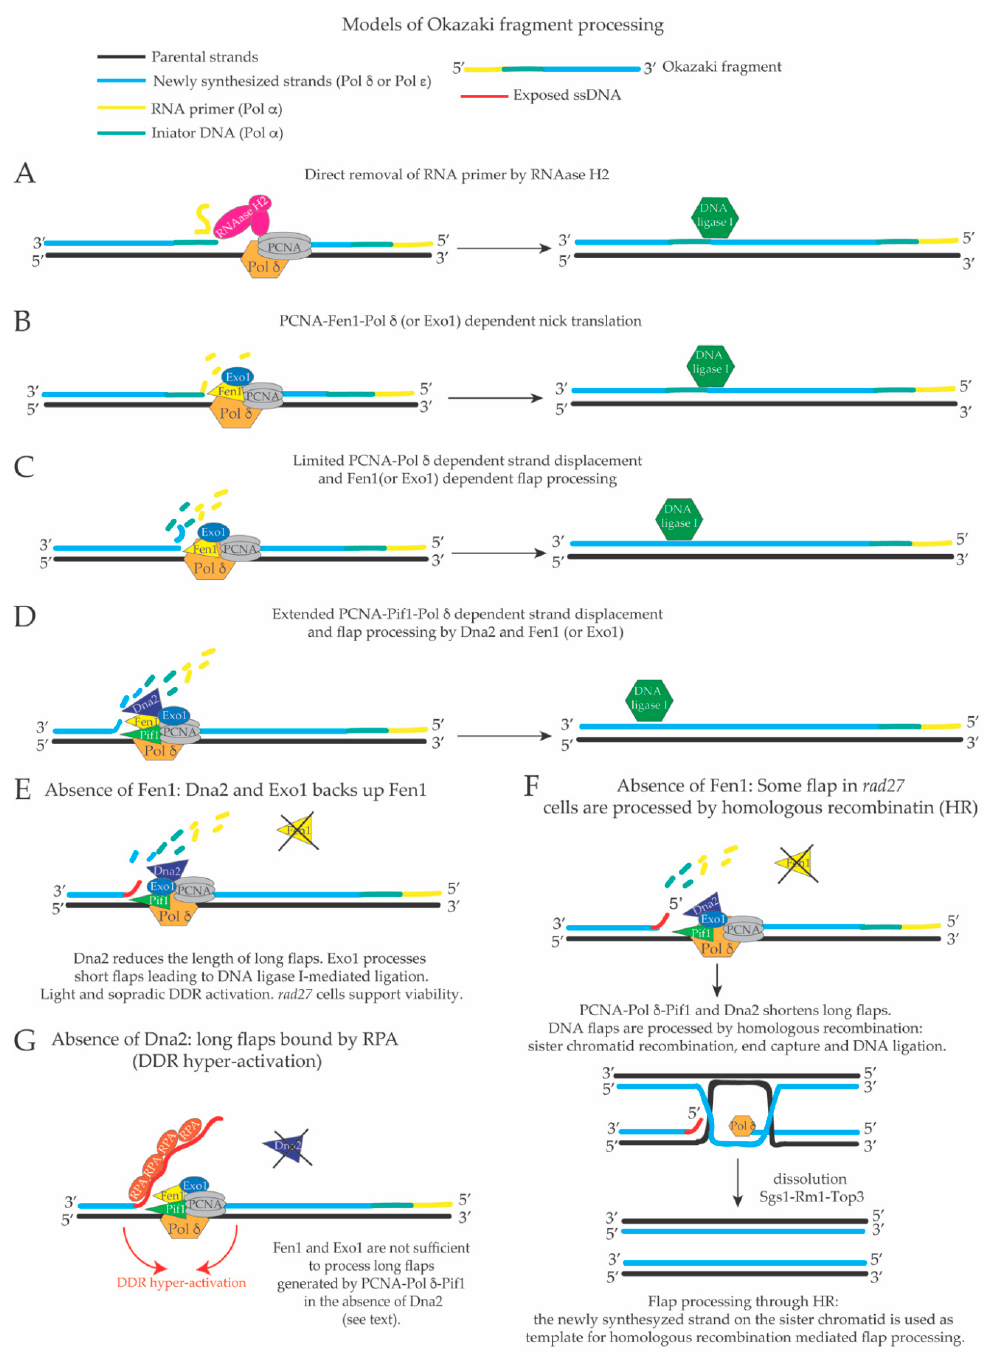
Figure 2. Possible mechanisms of Okazaki fragments (OF) maturation in S. cerevisiae . ( A ) Direct removal of the RNA primer by RNase H2 combined with limited Pol δ -mediated DNA synthesis leads to the formation of a ligatable nick, which is a substrate for DNA ligase I. ( B ) Limited strand displacement of the 5’ end of the last OF by Pol δ (due to DNA polymerase idling) displaces a single nucleotide that is cut by Fen1 or Exo1. Iterative cycles of Pol δ -Fen1 or Pol δ -Exo1-dependent nick translation will remove the RNA primer and create a ligatable nick for DNA ligase I. ( C ) More cycles of nick translation will remove also the initiator DNA previously synthesized by Pol α . ( D ) Extended Pif1-PCNA-Pol δ -dependent strand displacement DNA synthesis proceeds beyond the initiator DNA. The displaced 5’ end cannot be cut by Fen1 and Exo1 and requires processing by Dna2. Once Dna2 has reduced the length of the displaced tail, short flaps become substrates for Fen1 or Exo1, which will create a ligatable nick for DNA ligase I (note sequential actions of Dna2 and Fen1). ( E ) In the absence of Fen1, Pif1-PCNA-Pol δ -dependent long flaps are shortened by Dna2 to a length that only